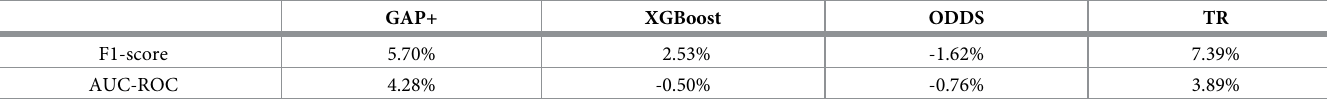
GAP+ (GAP+ Team Rating+ Competition round), ODDS (Betting odds), and TR (Team Rating Only) are baseline models. XGBoost is the match results forecasting model in our proposed